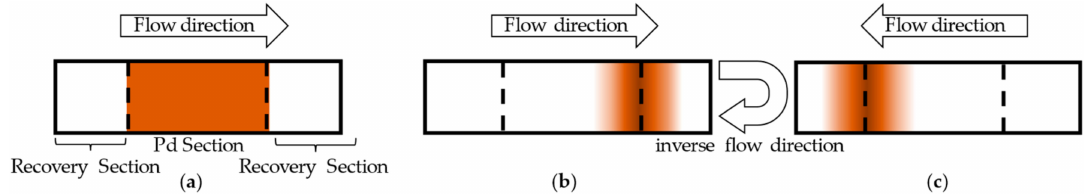
Figure 4. Methodology of a “Palladium Reverse Flow Reactor”; ( a ) initial situation of a packed bed of the Pd catalyst in the middle and recovery sections at the front and end; ( b ) active species is pushed in flow direction towards the end of the column to the recovery section, flow direction is inverted; ( c ) active species is pushed towards the former front of the system; orange color represents position of active